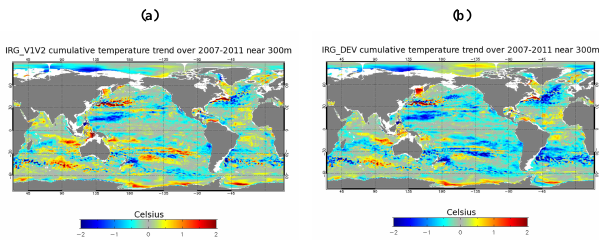
Fig. 27. 1 st EOF of surface temperature increment made every 7 days (°C) over the 2007-2010 2 Fig. 27. 1st EOF of surface temperature increment made every period for IRG_V1V2 (a) and IRG_DEV (b) systems. The time series at the bottom of each 3 7days ( ◦ C) over the 2007–2010 period for IRG V1V2 (a) and panel correspond to the mode amplitude. 4 IRG DEV (b) systems. The time series at the bottom of each panel corresponds to the mode